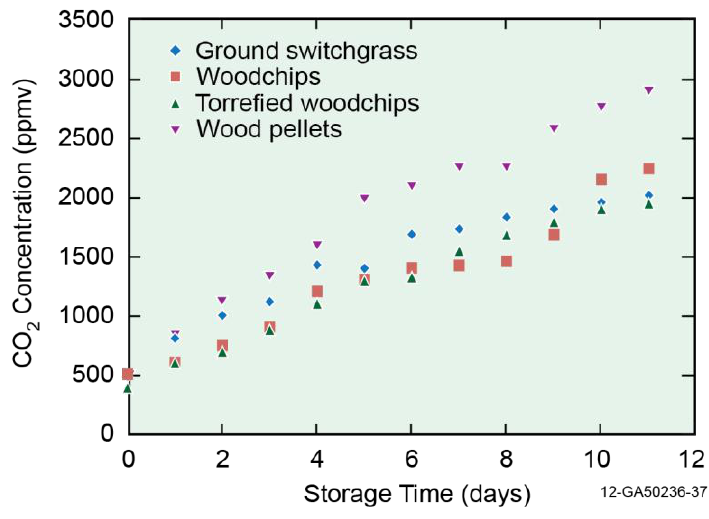
Figure 4. CO 2 concentration at 20 °C storage